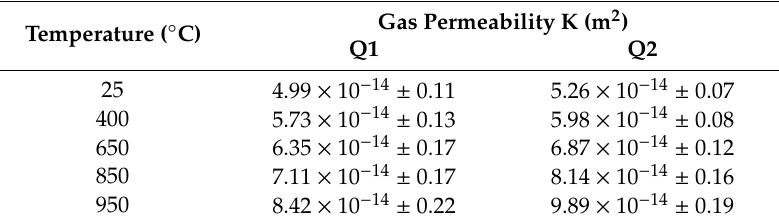
Table 6. Gas permeability of the ceramic samples, Q1 and Q2.